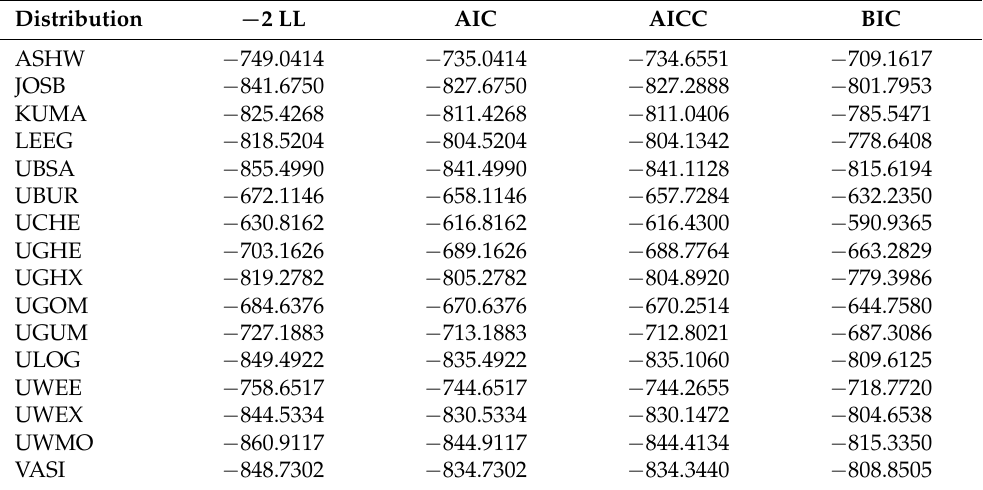
Table 13. Values of the indicated likelihood-based statistic and distribution for τ = 0.50 with data related to fat percentage at the legs.